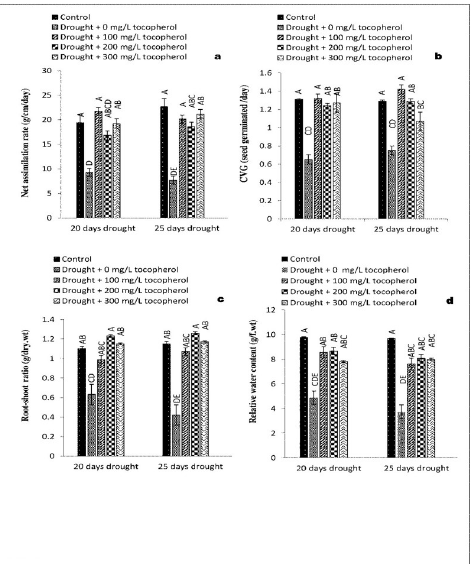
Fig 2. Effect of varying levels of exogenously applied α -tocopherol on net assimilation rate (a) coefficient of velocity of germination (b) root-shoot ratio (c) relative water content (d) of lentil ( Lens culinaris Medik.) grown under varying drought stress condition (Mean ± standard error.) letters (A–E) indicating least significance difference among the mean values at p � 0.05.